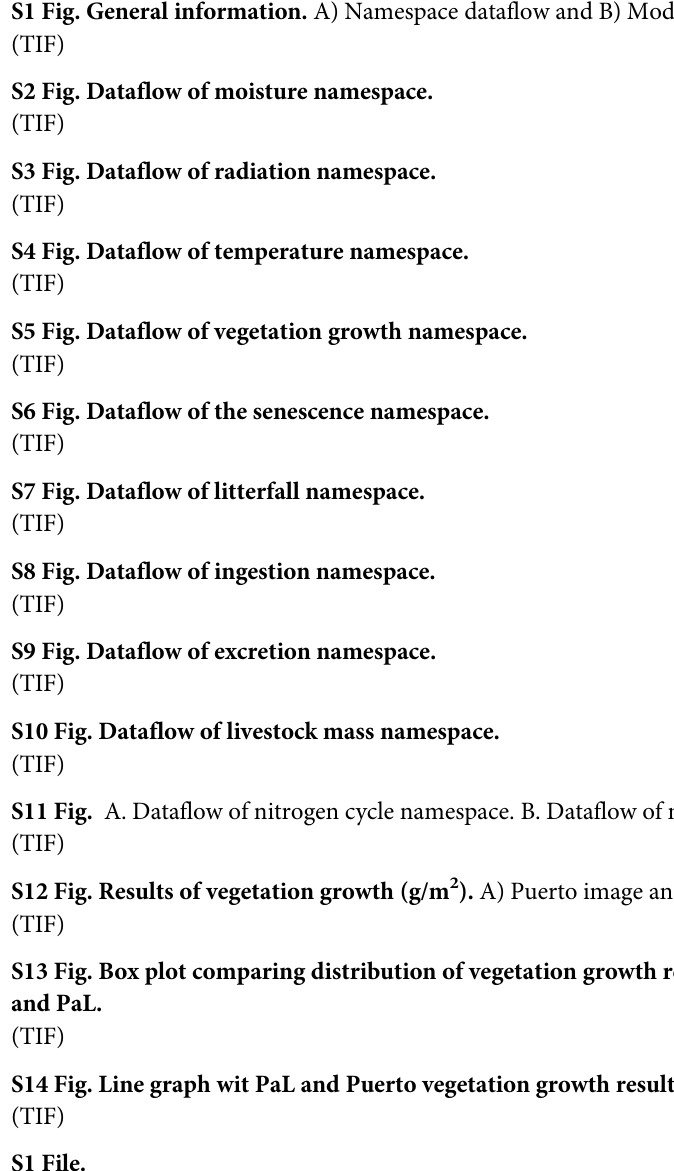
S13 Fig. Box plot comparing distribution of vegetation growth results by plot for Puerto and PaL. S14 Fig. Line graph wit PaL and Puerto vegetation growth results by